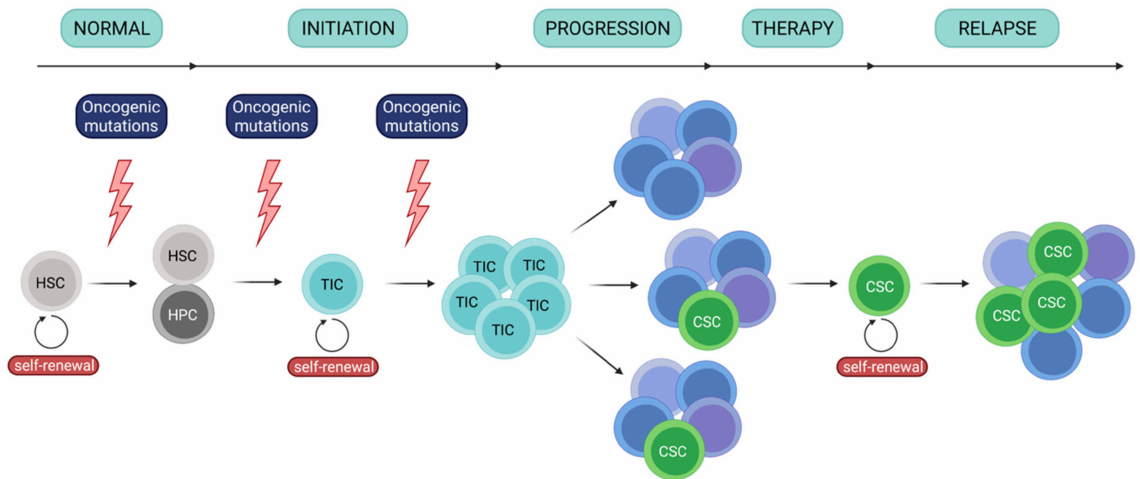
Figure 1. Scheme of leukemia initiation, development and relapse. Leukemia develops from tumor initiating cells, following oncogenic mutations. As leukemia develops, small population of cancer/ leukemia stem cells is maintained and enables disease relapse after therapy. HSC - hematopoietic stem cell; HPC - hematopoietic progenitor cell; TIC - tumor initiating cell; CSC - cancer stem